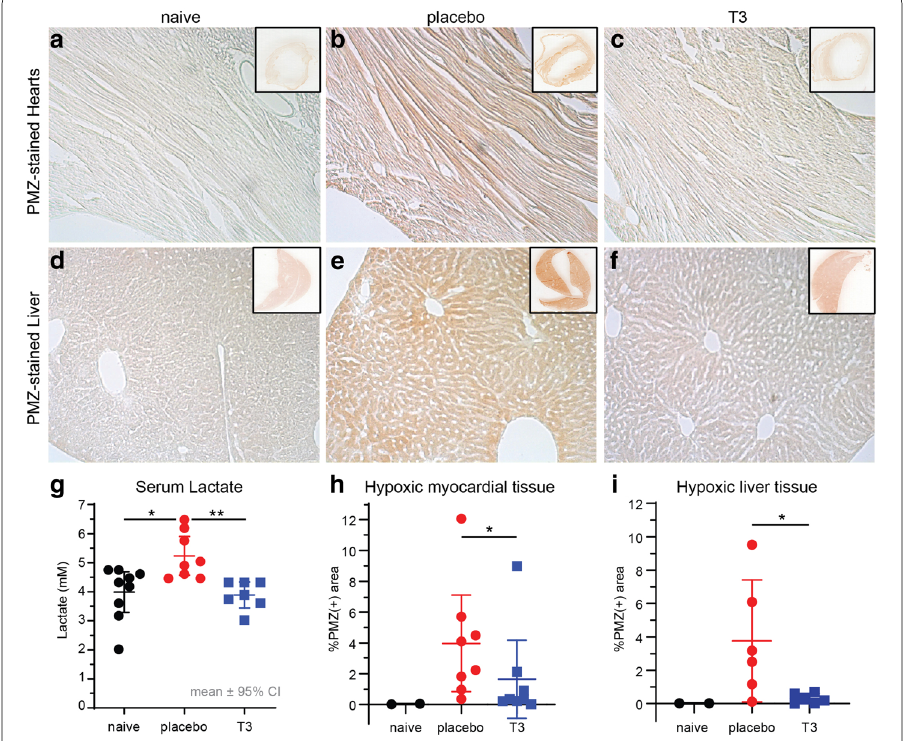
Fig. 1 Representative microscopy images after pimonidazole (PMZ) staining from heart and liver tissues of naive ( a and d ), placebo ( b and e ) and T3-treated ( c and f ) animals. Detection of hypoxia (PMZ positive) was based on immunoperoxidase staining (brown color). Analysis of the pictures for detection of the PMZ-positive signal and area was performed in ImageJ using the "Threshold Color" function. Selection of threshold values was based on stained sections from naïve animals. "PMZ-positive" % area of the heart and liver tissue was identified as the percentage of pixels with color above the set threshold to total pixels in each picture. Background areas with no tissue were removed from the calculation. g Lactate levels in serum were 5.2 0.28 mM in placebo and 4.2 0.35 in T3-treated group 18 h after surgery, p < 0.05. Baseline lactate levels ± ± in naive animals were 4.1 0.3 mM, p < 0.05 vs placebo only. h Quantification of PMZ-positive staining in left ± ventricular tissue was 4% 0.5 in placebo and 1.5% 0.5 in T3-treated hearts 18 h after surgery, p 0.028. i ± ± = PMZ-positive staining in liver was 3.8% 1.4 in placebo and 0.3% 0.1 in T3-treated hearts, p 0.026. Results ± ± = are presented as mean SEM. * p < 0.05 vs ±